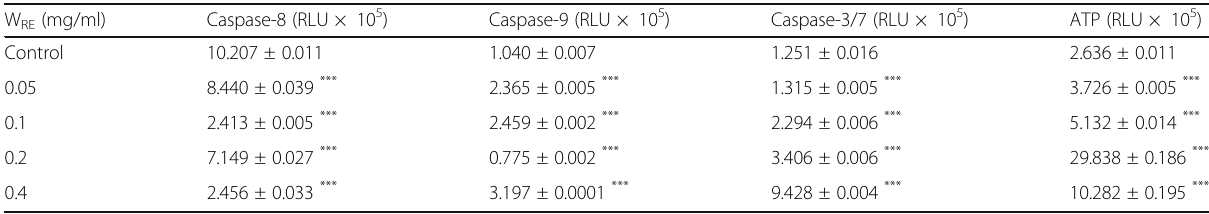
(Values expressed as mean±SD, *** p <0.0001 compared to the